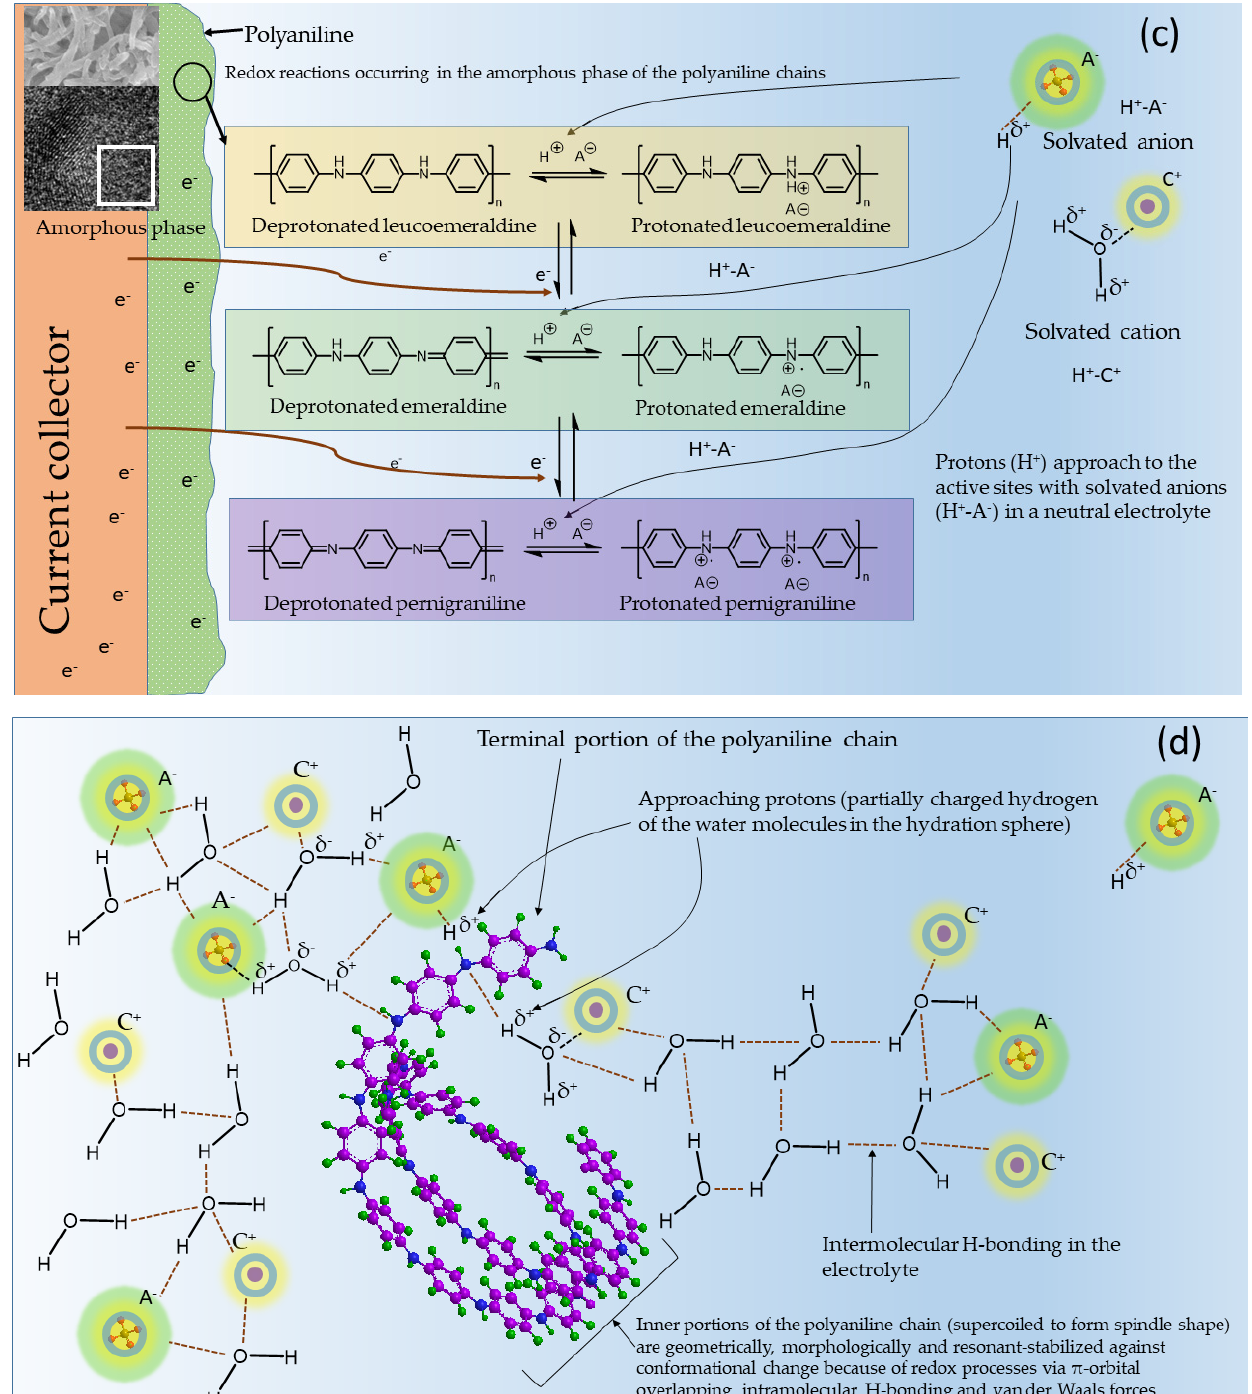
Figure 14. ( a ) Structure of a solvated cation and formation of primary and secondary hydration spheres; ( b ) formation of electrical double layer at the crystalline phases in the semi-polycrystalline polyaniline matrix via accumulation of charged ions; ( c ) the different redox stages in the polyaniline molecule (in the amorphous phase of the polyaniline matrix) involving electrons and protons; ( d ) approaching partially charged protons associated with anions and cations in a neutral electrolyte (H + –A − )/(H + –C + ) at the N-sites of the terminal portion of the polyaniline chains. The pseudocapacitance in the polyaniline matrix arises due to reversible surface qui- nonoid reactions and partial charge transfer during electrosorption of (H + –A − )/(H + –C + ) species at the N-sites of the polymer chains, resulting in oxidation of the material and change in the conformation of the molecule at the respective sites. There is no phase change of the material upon redox reaction, and the process is completely reversible. Hence, these cannot be termed as Faradaic reactions. Moreover, the redox reactions oc- curring in the polyaniline molecule is largely restricted at the surface of the material, as the inner portions remain dormant against conformational changes because of redox re- action. In addition, the redox reactions are highly reversible. Therefore, the pseudocapac- itance observed in the electrochemical behavior is technically a non-Faradaic reaction and is termed as surface-redox pseudocapacitance [32,38]. 7. Conclusions We synthesized novel semi-polycrystalline polyaniline using a modified surfactant- free chemical route. The microstructural and phase analysis of the material exhibits well- defined properties of a crystalline material. The material shows enhanced electrochemical properties as well. The cyclic voltammograms show almost rectangular curves character- istic of capacitive behavior with a slight mix of deformation indicative of pseudocapaci- tive features. The specific capacitance calculated for the material is 551 F g − 1 at the scan rate of 10 mV s − 1 . The life span and function of the polyaniline-based supercapacitor elec- trode is a crucial parameter, which gauges the long-term application in electronic gadgets. Here, the cycle stability and the coulombic efficiency are measured at a high current den- sity of 12 A g − 1 , exhibiting good stability (90.3% and 99.5%, respectively) over 3000 cycles.